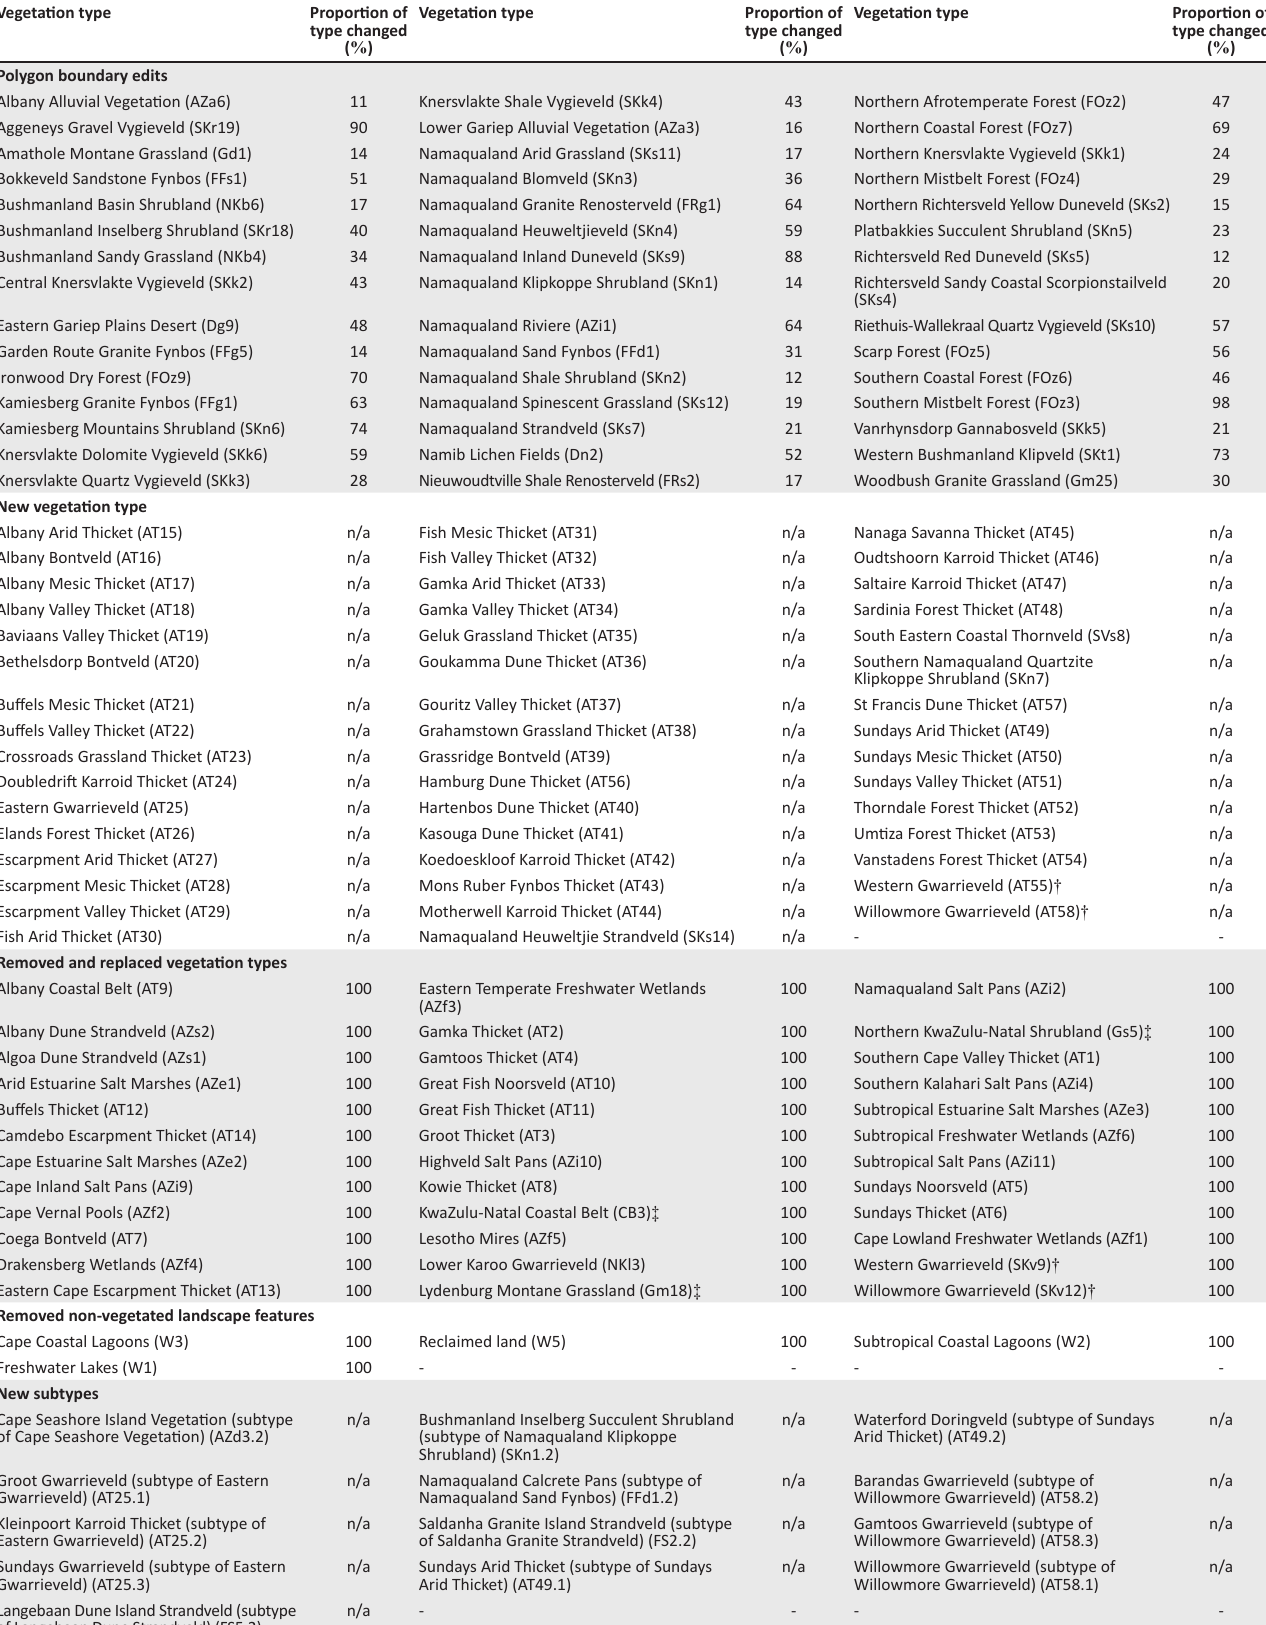
TABLE 2: Vegetation types affected by changes (i.e. boundary shifts of existing vegetation types, vegetation types and subtypes added, vegetation types removed, and deleted non-vegetated landscape features) in the 2018 version of the National Vegetation Map. Vegetation